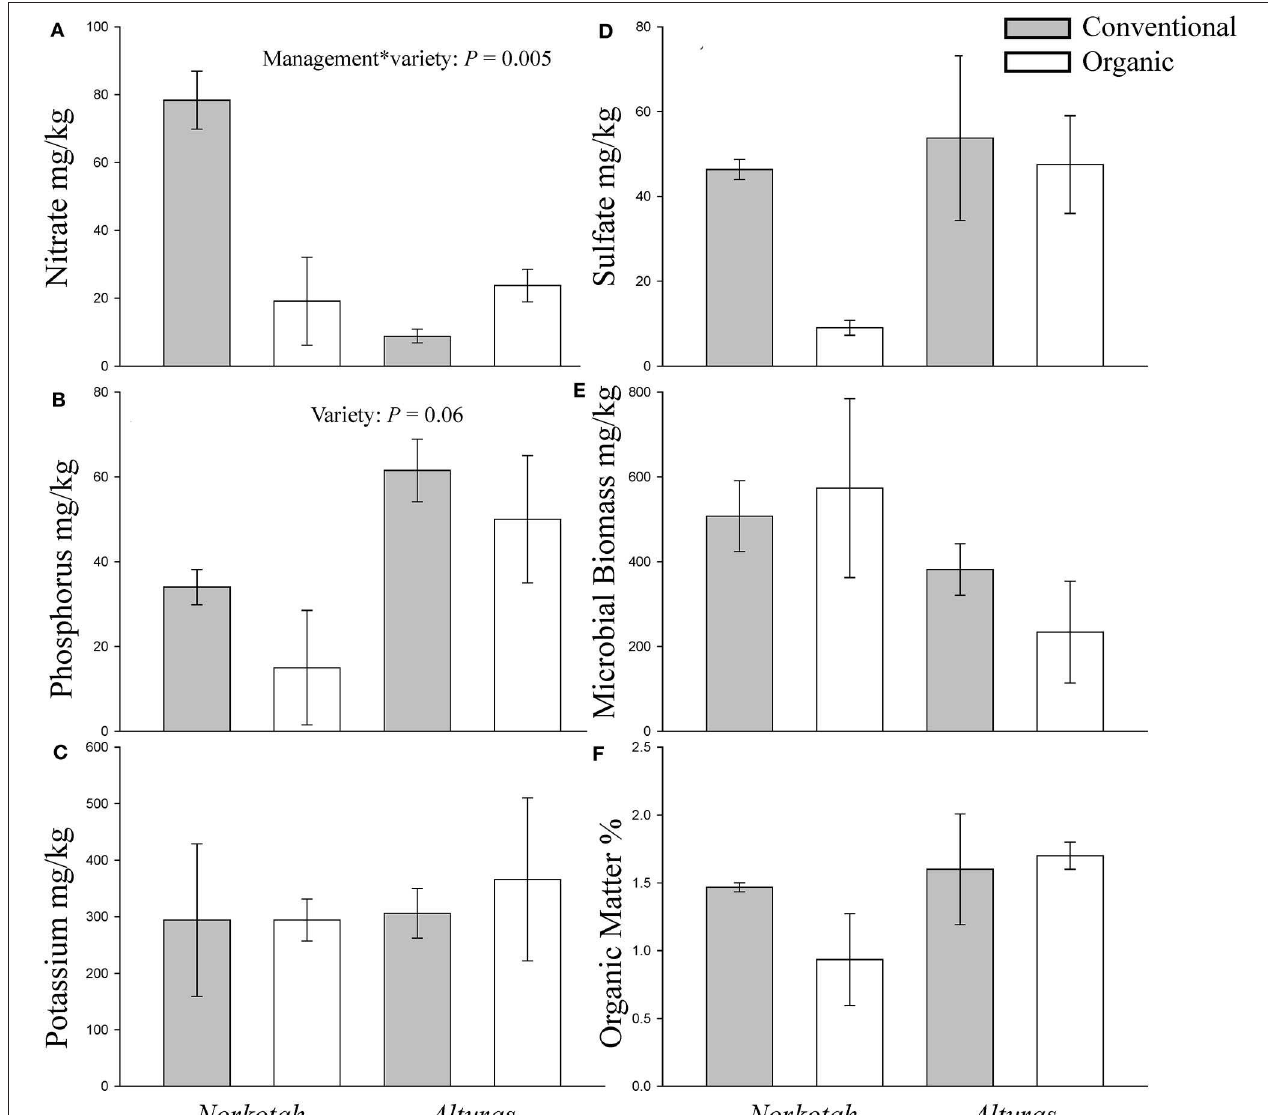
FIGURE 4 | Concentrations of nutrients in soil collected from organic and conventional potato fields at mid-season. (A) Nitrate, (B) phosphorus, (C) potassium, (D) sulfate, (E) microbial biomass, and (F) organic matter. Gray bars indicate conventional soil and white bars